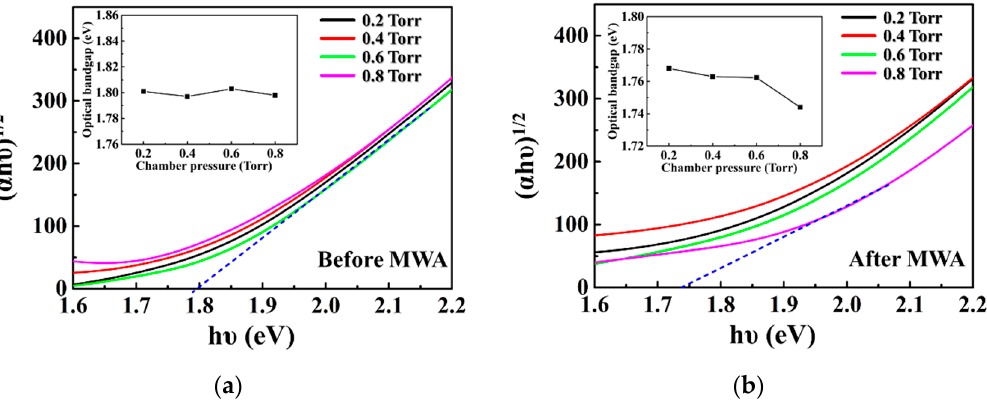
Figure 9. Optical bandgap of the thin film ( a ) before using microwave annealing and ( b ) after microwave annealing at different chamber pressures. in all cases, the MWA power was 440 W, the annealing temperature was 180 °C, and the MWA time was 20 min.